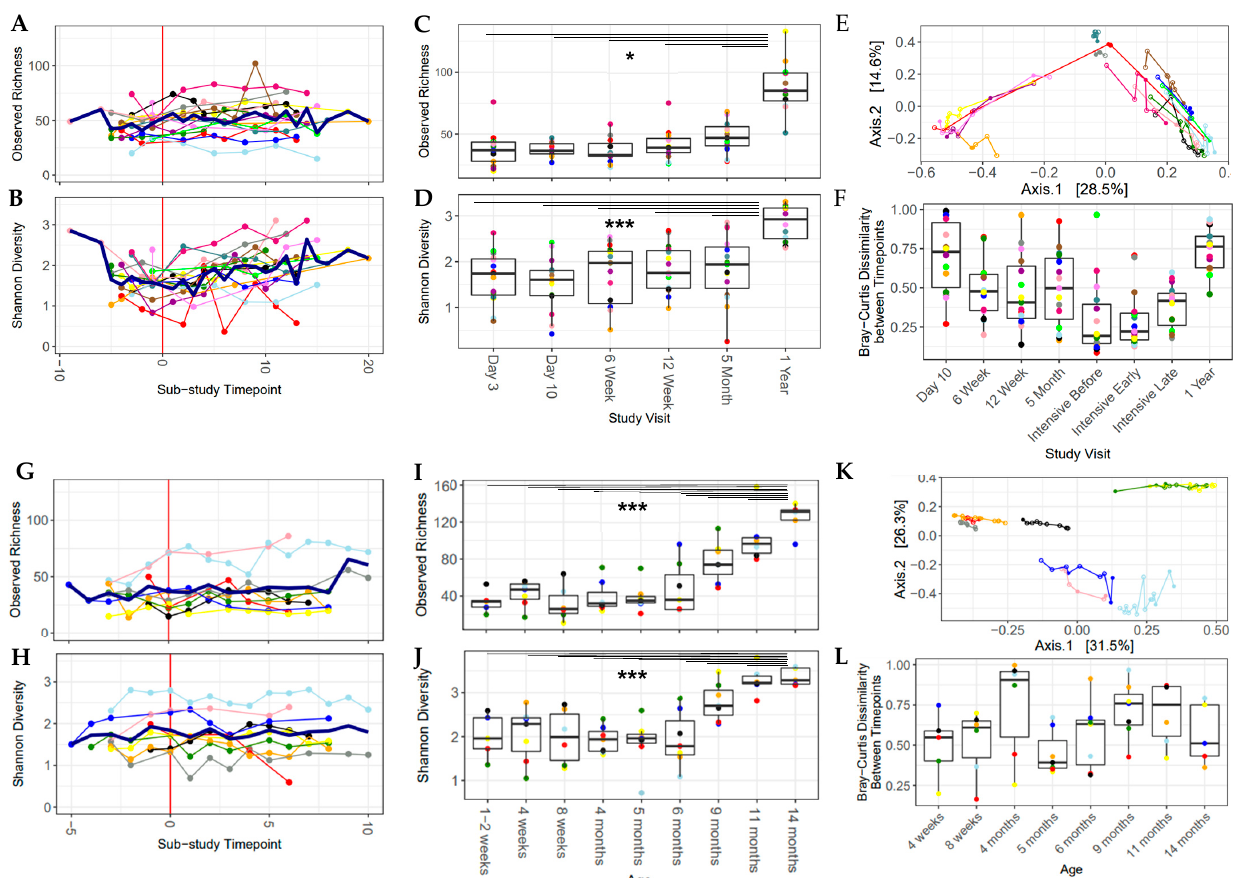
Figure 3. Alpha diversity increased over the sub-study period and over the first year of life. Bray–Curtis dissimilarity over time shows that the gut microbial community was dynamic over the first year of life. All plots are colored by participant ID (PID). ( A – F ) Baby, Food & Mi sub-study; ( G – L ) LucKi-Gut sub-study. ( A , G ) Observed richness over the sub-study period, mean values are shown with a thick blue line. ( B , H ) Shannon diversity over the sub-study period, mean values are shown with a thick blue line. ( C , I ) Observed richness over the first year of life. ( D , J ) Shannon diversity over the first year of life. ( E , K ) PCoA plot of the sub-study samples. ( F , L ) Change in Bray–Curtis dissimilarity between each study visit and the one previous to it. (* p < 0.05, *** p < 0.001).